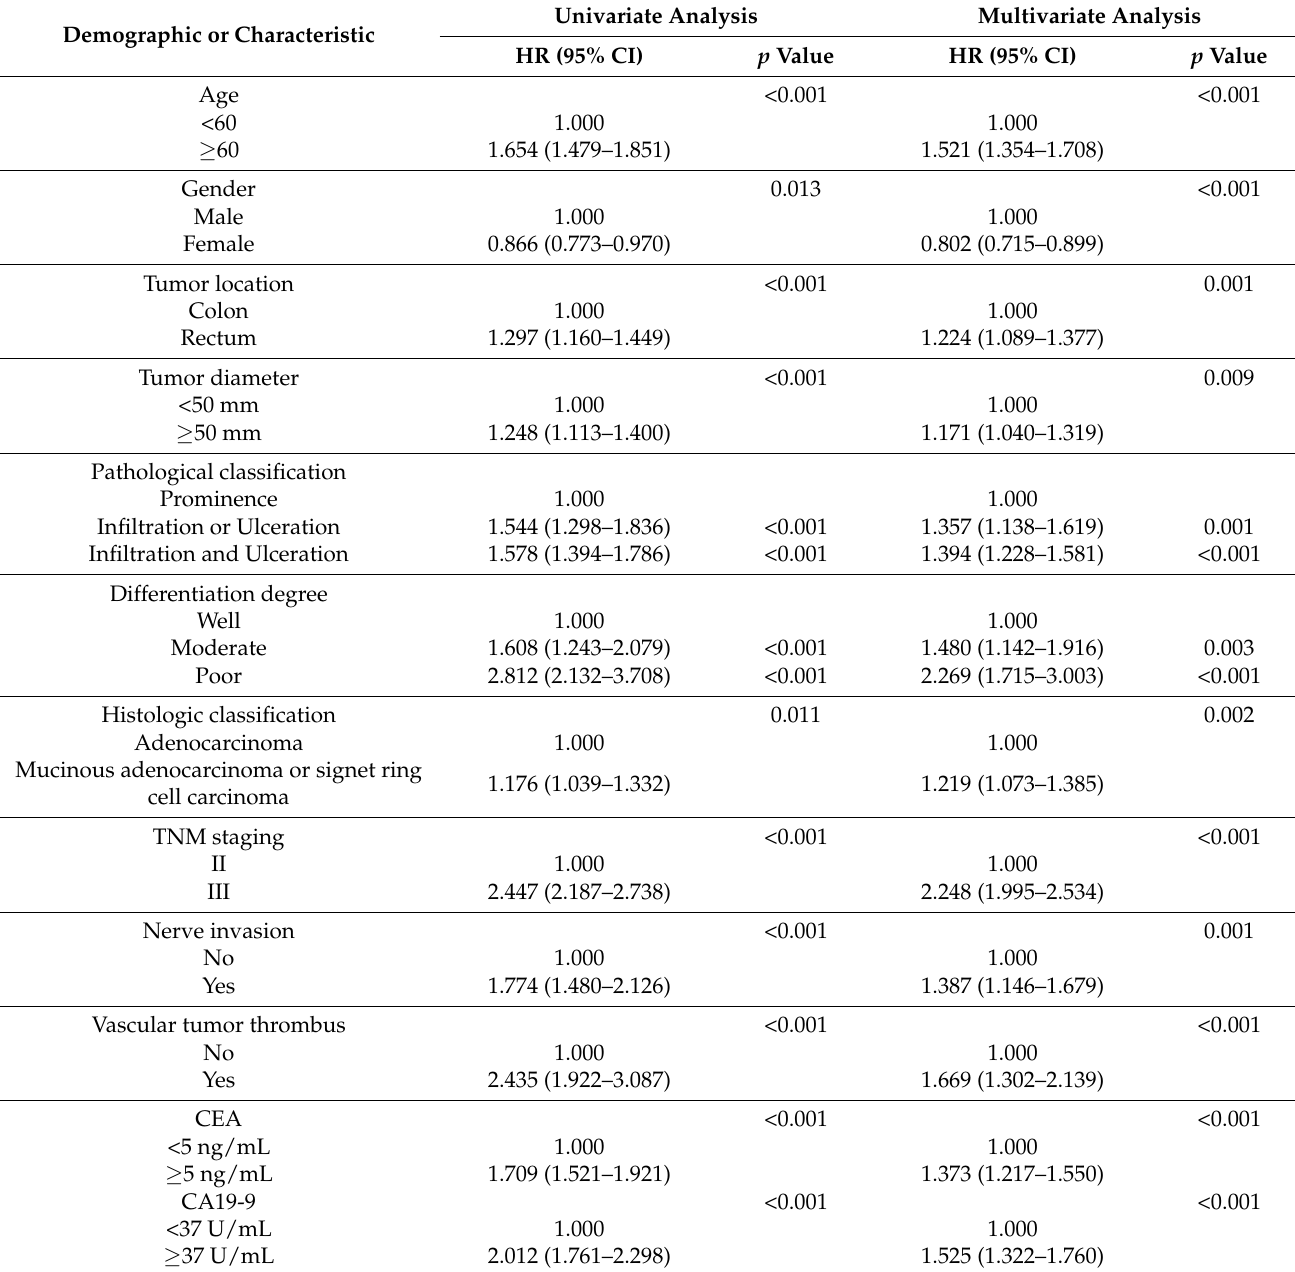
(Table 2). Adjusting for age, gender, tumor location, tumor diameter, pathological classifica- tion, differentiation degree, histologic classification, TNM staging, nerve invasion, vascular tumor thrombus, CEA, CA19-9, postoperative chemotherapy and radiotherapy in the mul- tivariate Cox analysis, OS-PII was still statistically associated with the OS of CRC (hazard ratio [HR]: 1.330, 95% confidence interval [CI]: 1.189–1.489, p < 0.001), which indicated that OS-PII was an independent prognostic predictor for CRC (Table 2). Table 2. Association between predictive factors and overall survival of CRC in the training cohort. Univariate Analysis Multivariate Demographic or Characteristic